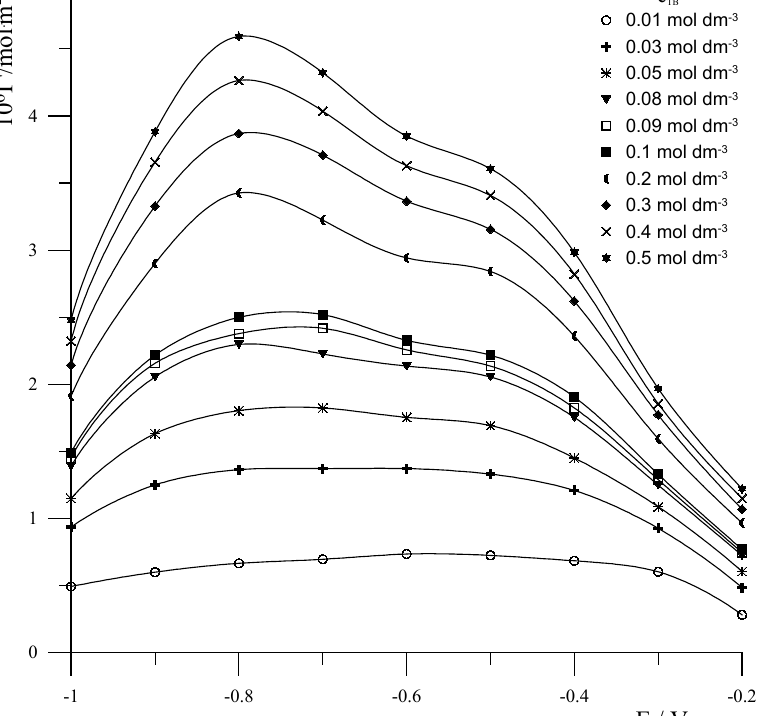
Figure 3. Relative surface excess of tert-butanol as a function of electrode potential and tert-butanol bulk concentration in 4 mol dm -3 NaClO